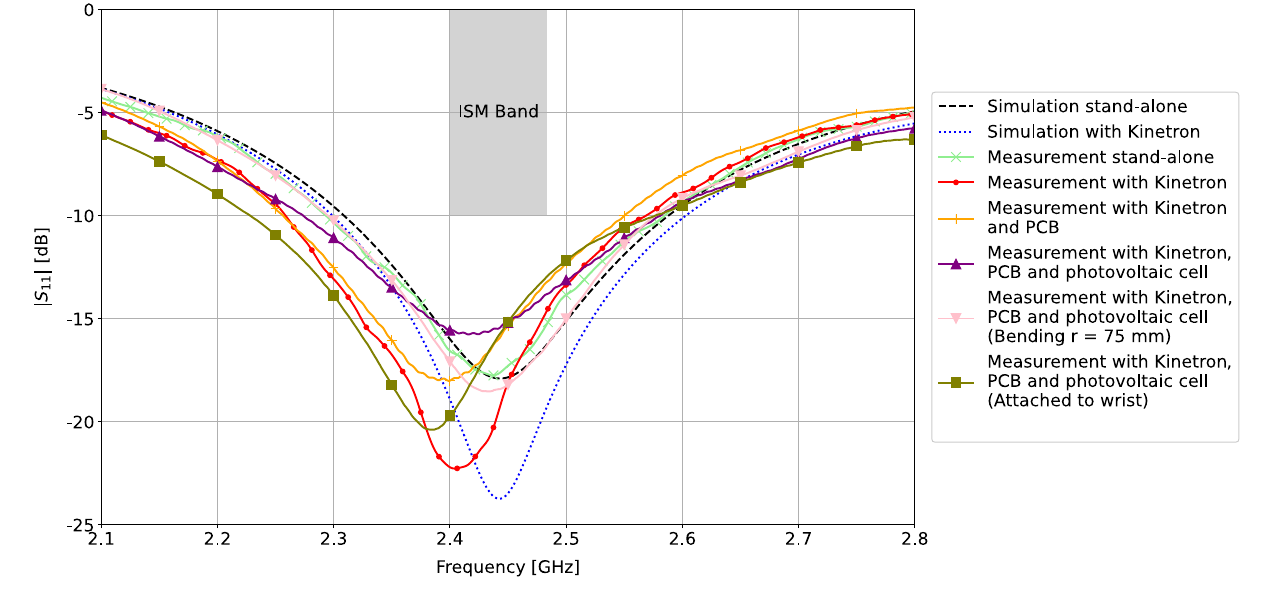
Figure 6. Simulated and measured reflection coefficient | S 11 | (dB) versus frequency, with and without Kinetron and photovoltaic cell. Simulation stand-alone free space, no harvesters nor electronic components present (full line), and with Kinetron (dashed line); measurement stand-alone free space, no harvesters nor electronic components present (marker ‘times’), and with Kinetron (marker ‘dot’), with Kinetron and PCB (marker ‘plus sign’), with Kinetron, PCB and photovoltaic cell (marker ‘upward triangle’), with Kinetron, PCB and